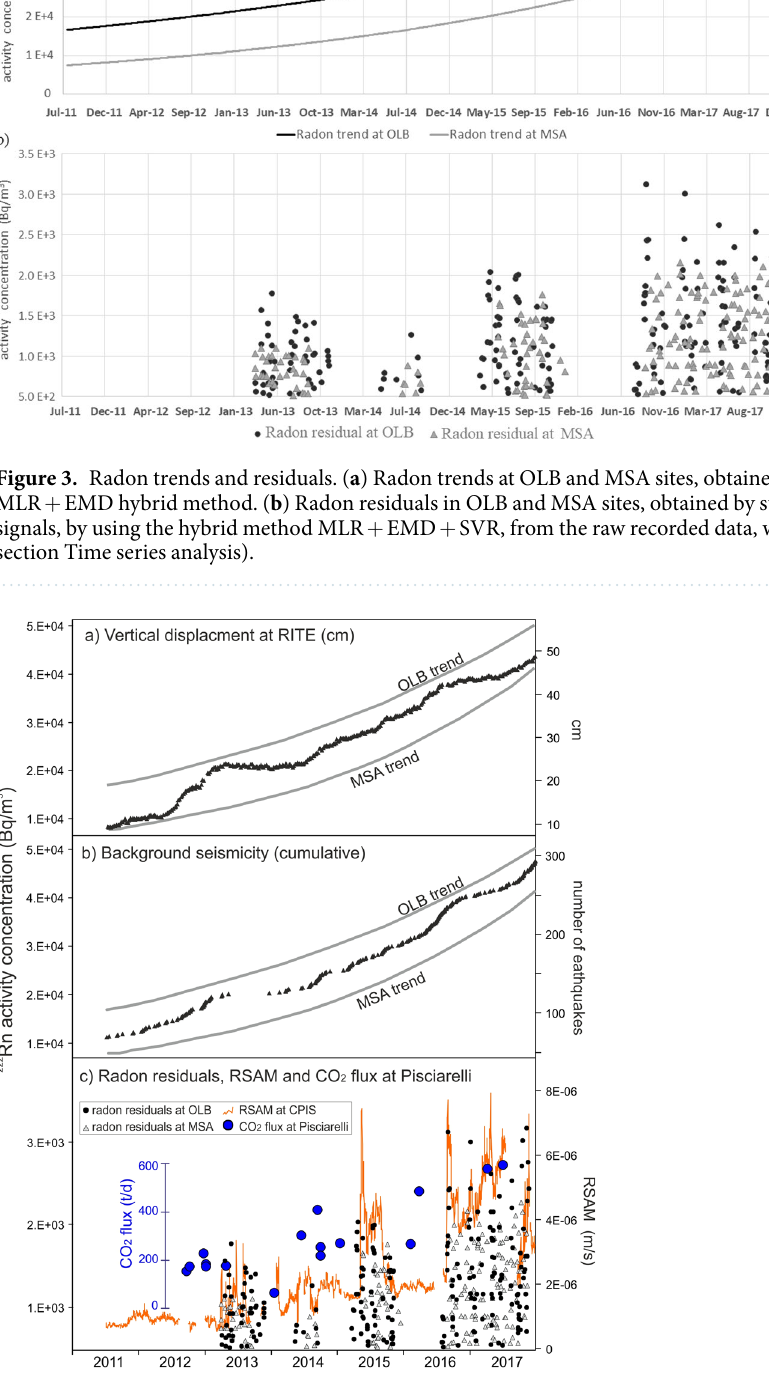
Figure 4. Comparison of the radon trends and residuals with independent geophysical signals. Radon trends at OLB and MSA sites compared with ( a ) maximum vertical displacement at Campi Flegrei (RITE continuous GPS station 45 ) and ( b ) background seismicity (i.e. the cumulative number of days with earthquakes since 2000 43 ). ( c ) Radon residuals, RSAM measured by CPIS station close to Pisciarelli fumarolic vent 41 , and CO 2 flux from Pisciarelli